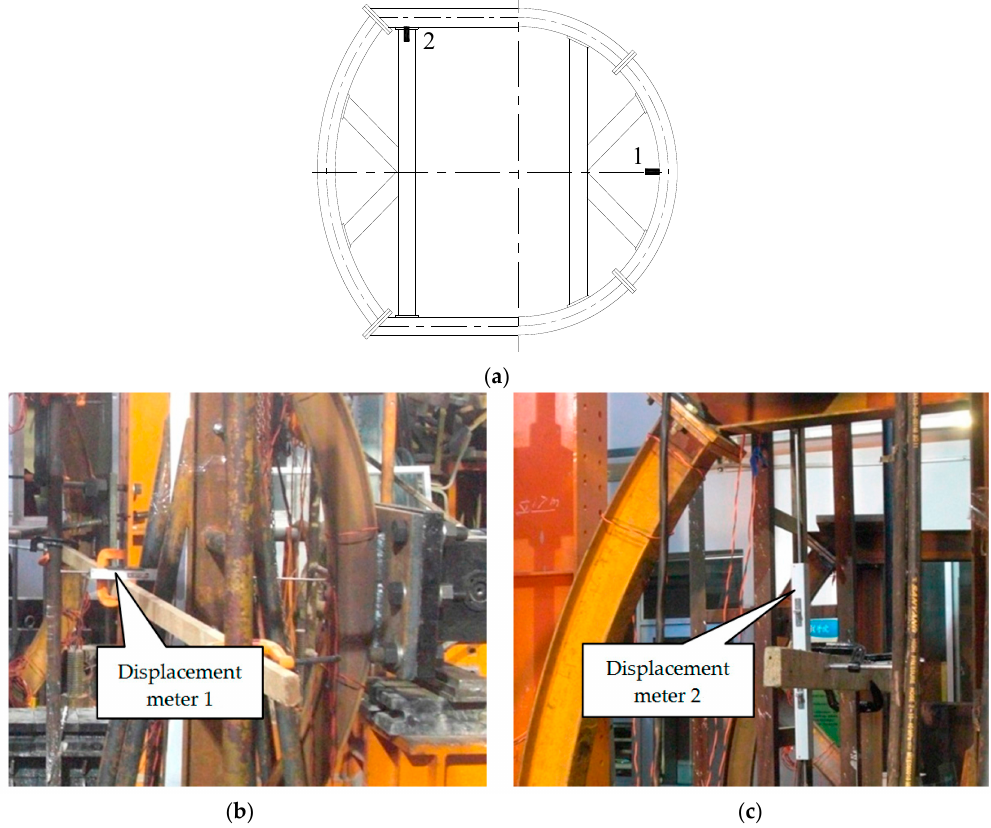
Figure 6. Layout of displacement meters: ( a ) layout schematic of displacement meters; ( b ) layout of meter 1; and, ( c ) layout of meter 2.